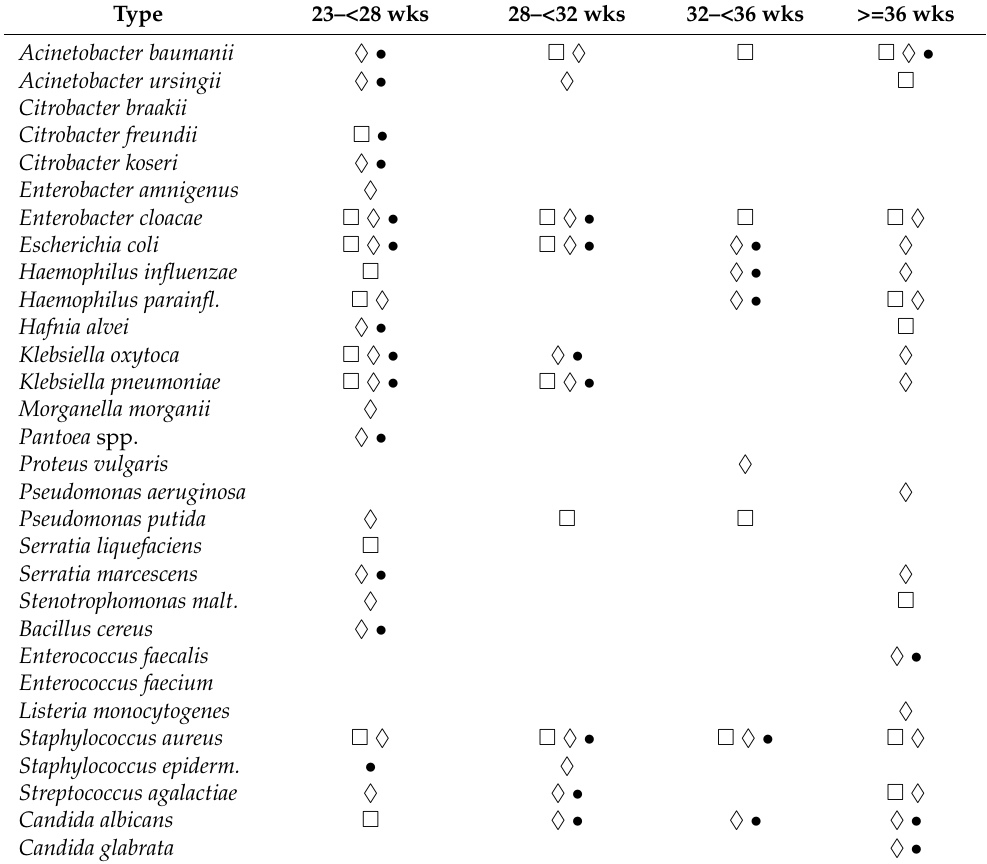
Table 4. Types of organisms isolated from throat swabs. (cid:3) Isolated from infants without sepsis. ♦ Isolated from infants with clinical sepsis. • Isolated from infants with blood-culture-proven